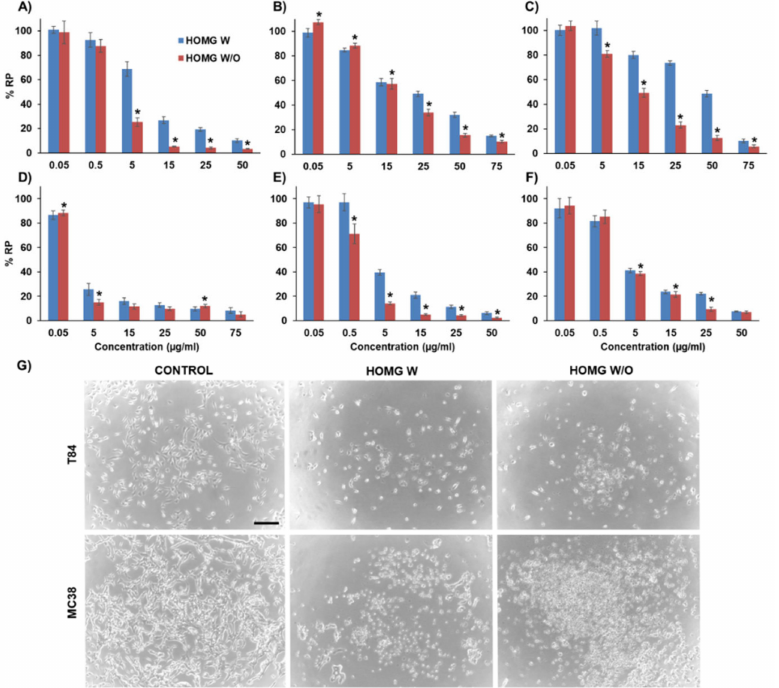
Figure 5. Antiproliferative activity of the crude homogenates in colon cells. T84 ( A ), HT29 ( B ), HCT15 ( C ) and SW480 ( D ) human colon cancer cells; MC38 murine colon cancer cell line ( E ); and CCD18 non-malignant human colon cell line ( F ) were exposed to the crude homogenates of Anemonia sulcata with (W) and without (W/O) the microalgal symbiont Symbiodinium for 72 h. Relative proliferation is expressed as %RP. Data are represented as the mean ± standard deviation of triplicate cultures. The symbol * indicates significant differences between crude homogenates with (W) and without (W/O) symbiont. Microscopy images of T84 and MC38 colon cancer cells treated with 25 µ g/mL of crude homogenates for 48 h ( G ). Control cells represent the untreated cells. The images were taken at 4 × magnification (scale bar = 200 µ